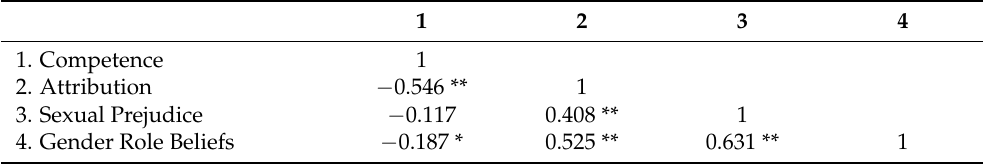
Table 1. Zero-Order Correlations Among